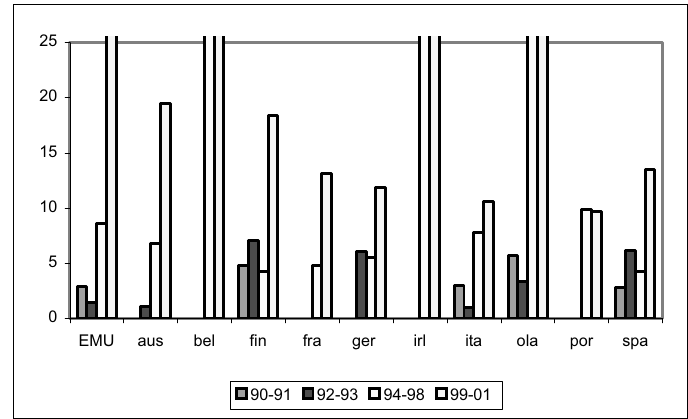
Figura 6 – Apertura finanziaria dei paesi dell'EMU, investimenti di portafoglio (somma di investi- menti di portafoglio effettuati all'estero dai residenti e di investimenti di portafoglio effettuati nel paese dai non residenti) in % del